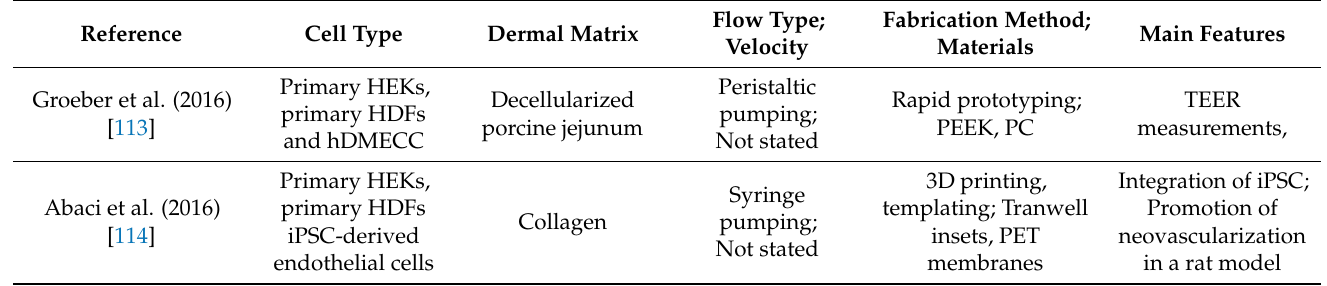
Table 2. Summary of the 3D SoC with perfusable lumens reported in the literature. Abbreviations: HEKs, human epidermal keratinocytes; HDFns, human dermal fibroblasts; iPSC, induced